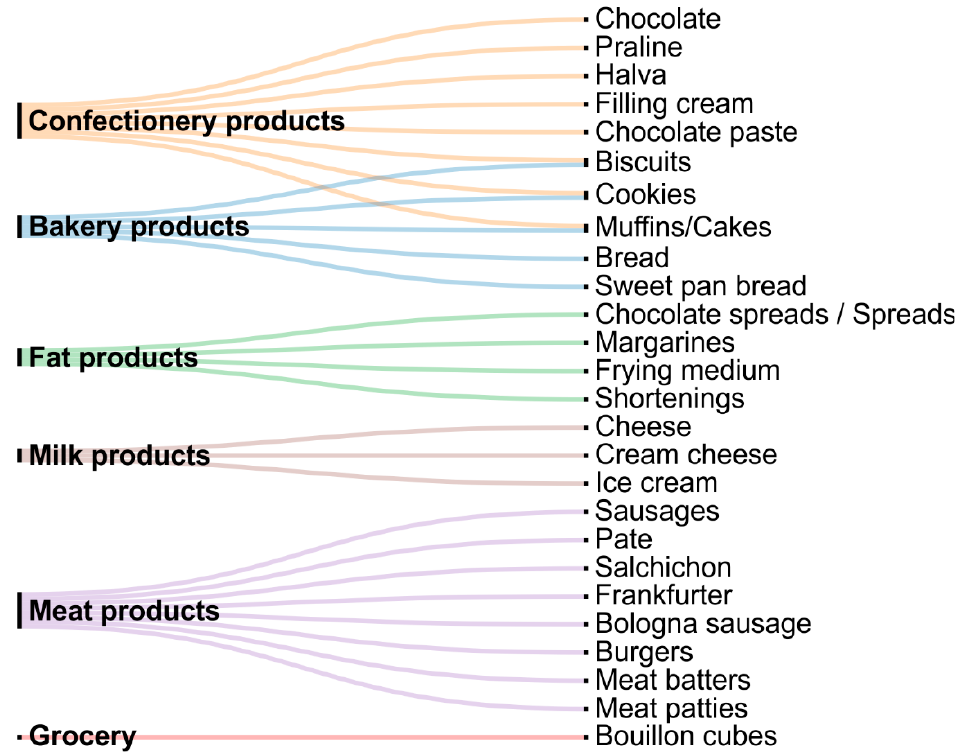
Figure 2. Application of oleogels and emulsion gels in various categories of food products.